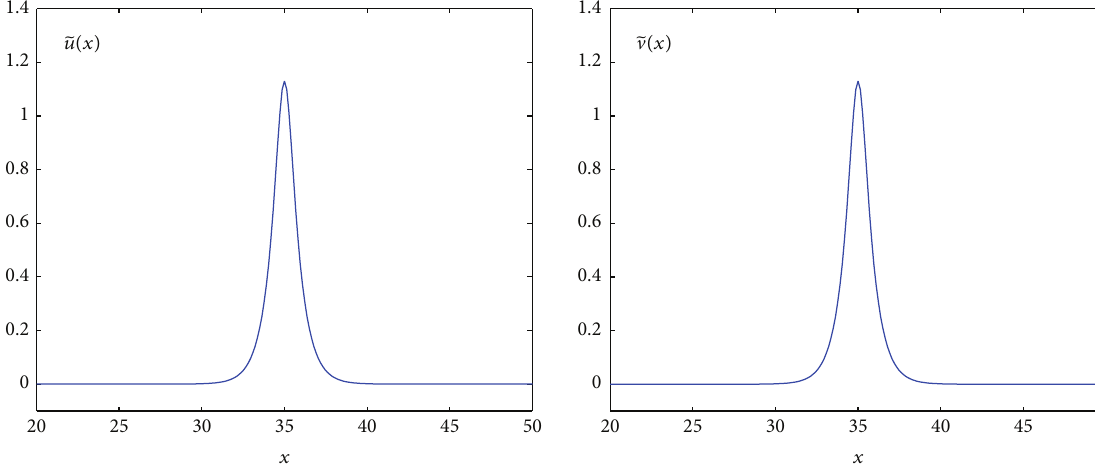
Figure 4: Vector soliton of system (1) obtained after 10 Newton’s iterations and 𝛿 = 1 , 𝜎 1 = 𝜎 2 = 0 , and 𝛼 1 = 𝛼 2 = 1.5